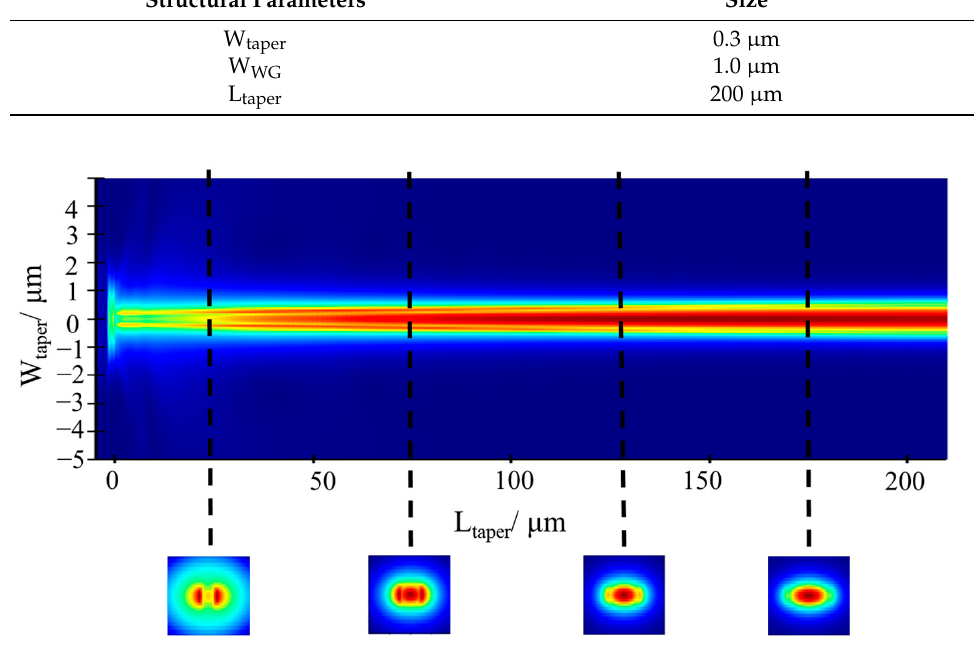
Figure 6. The field distribution of the light transmission in the inverse tapered edge coupler at 1550 nm.